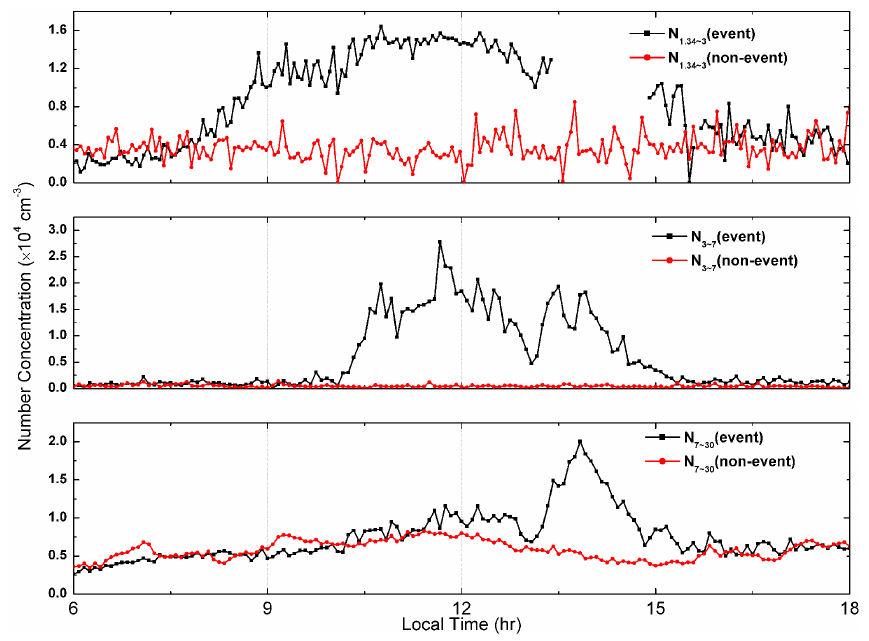
Figure 2. Profiles of N 1 . 34 ∼ 3 , N 3 ∼ 7 , and N 7 ∼ 30 from 6 a.m. to 6 p.m.UTC + 8 on a NPF day (11 December 2013) and a non-NPF day (7 January